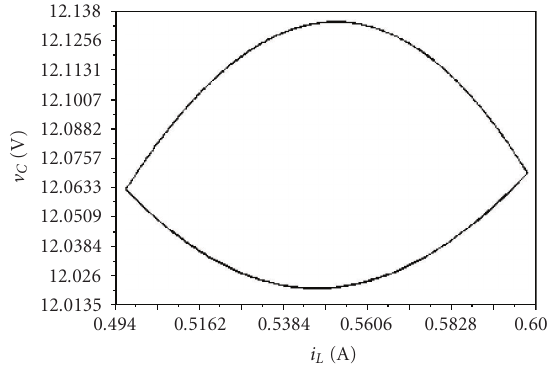
Figure 6: Fundamental periodic operation. ( E = 30V): phase